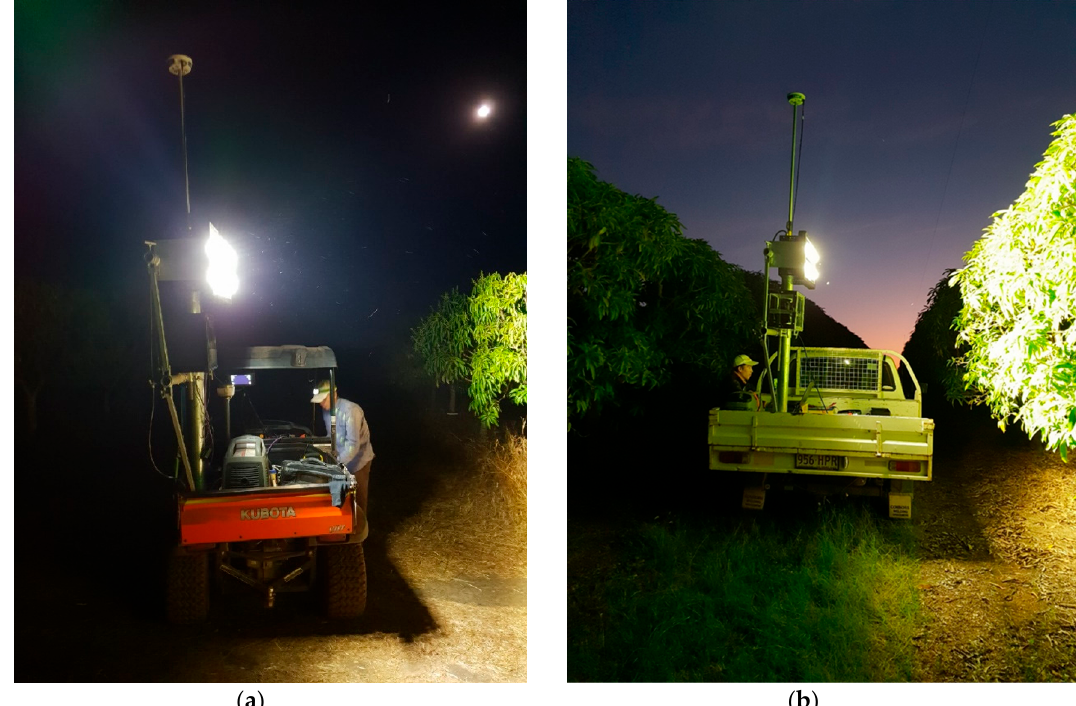
Figure 1. Automated imaging platform, involving a GNSS device (on pole), a 720 W LED floodlight, and a camera, powered by an inverter-generator and mounted on a farm vehicle (( a ) buggy or ( b ) utility), operated at 5 km/h.